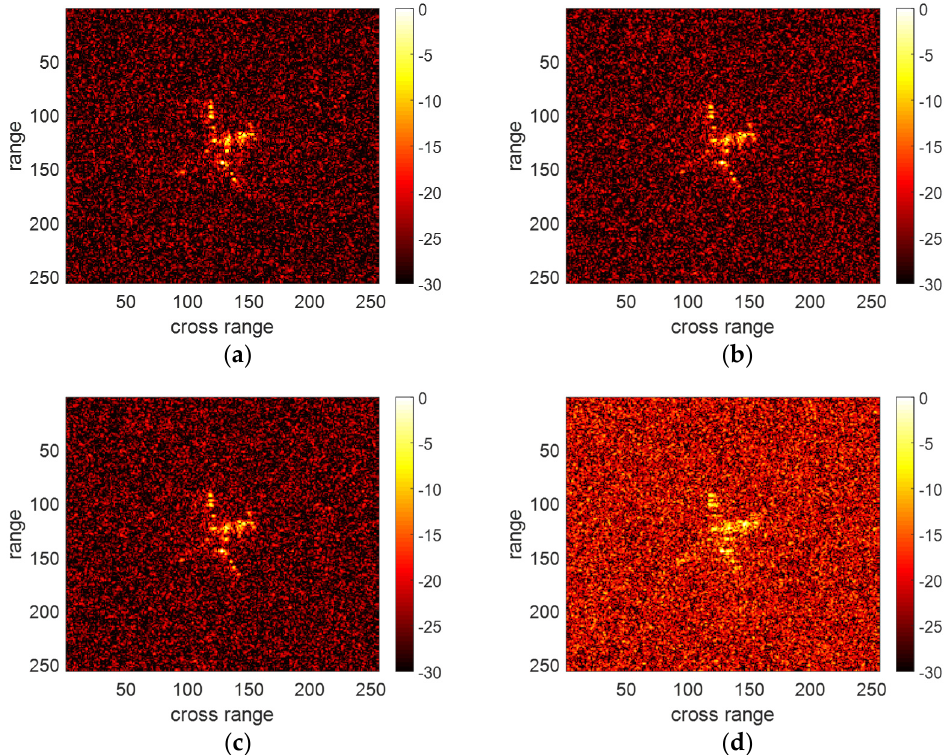
Figure 9. The results of the proposed method under the conditions of SNR = − 9, − 10, − 11 and − 12